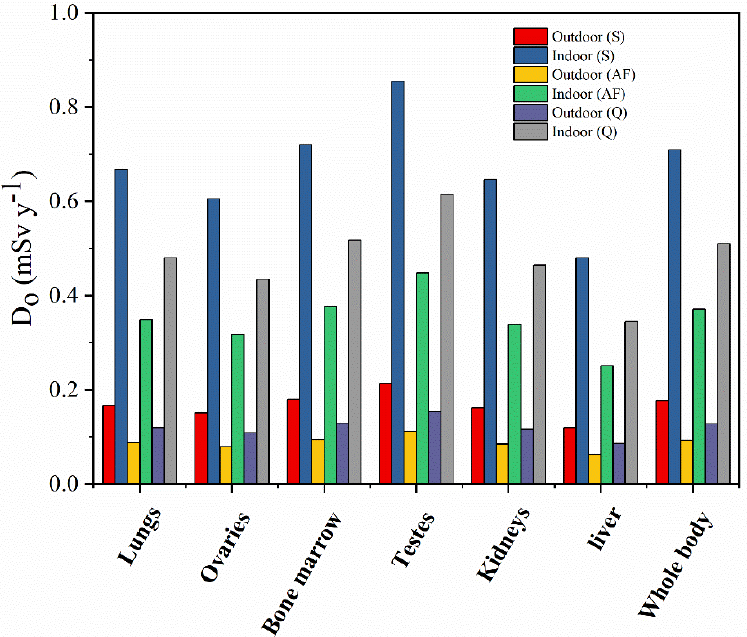
Figure 10. The effective dosage rate D o (mSv/y) associate with various tissues from air dose outdoor and indoor of syenogranite, alkali feldspar granite, and quartz syenite.